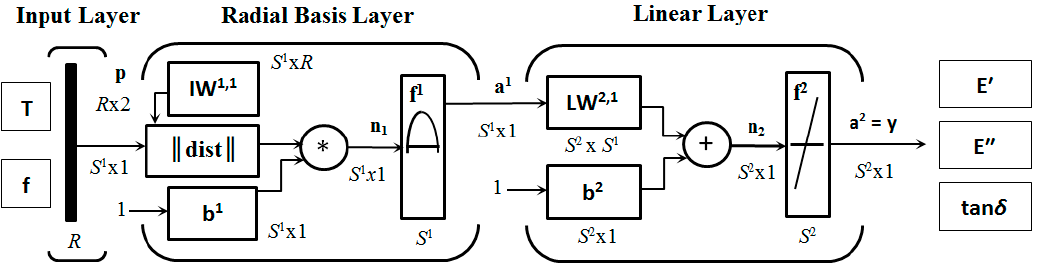
Figure 1. Diagram of the RBF-ANN structure for DMA multi-frequency spectrum prediction.